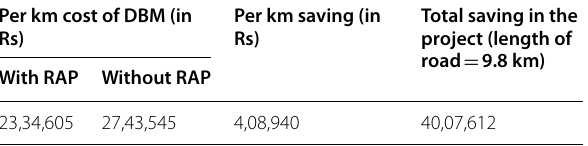
Table 9 Comparison of the